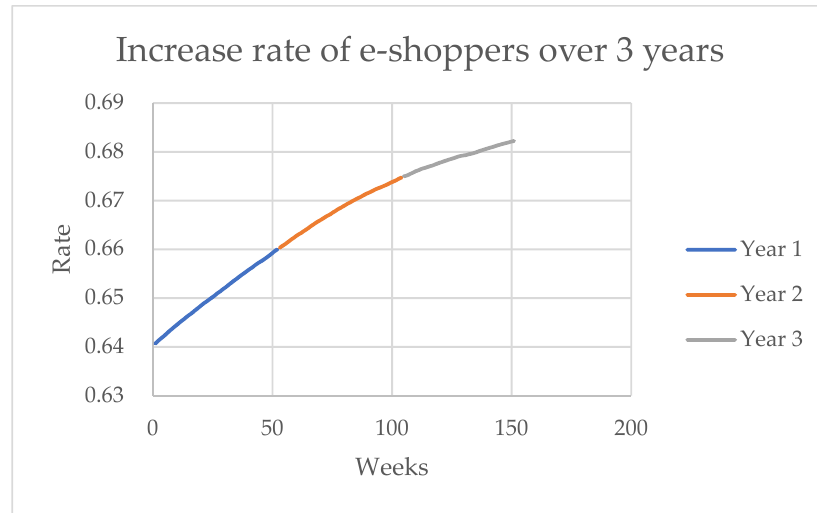
Figure 3. E-shoppers evolution rate over 3 years. Table 5. E-shoppers results for each year.